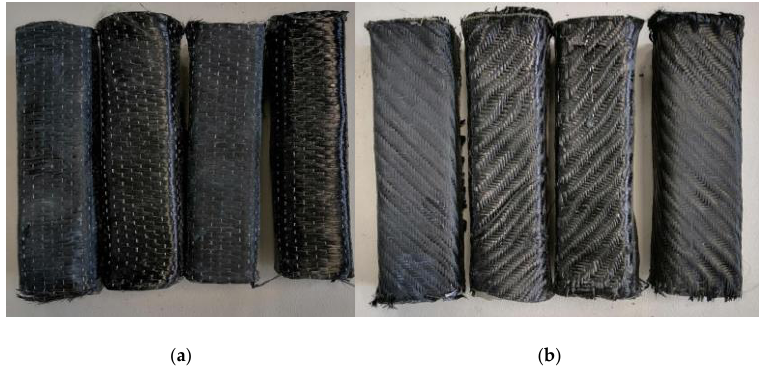
Figure 7. All carbon fiber reinforcement cases of cement specimens: ( a ) case of unidimensional fabric; ( b ) case of twill fabric.